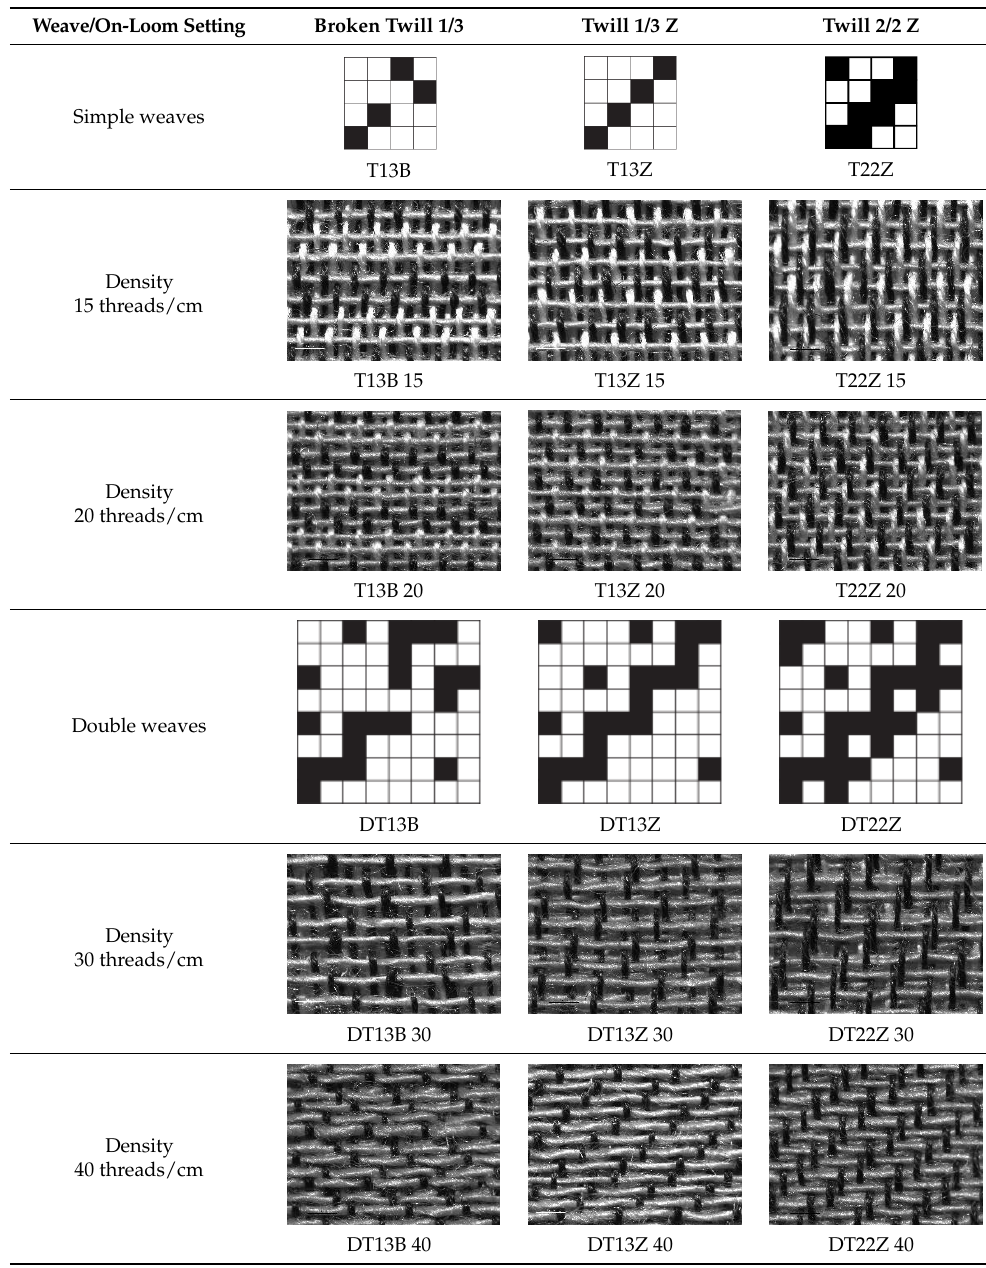
Table 1. Woven fabric samples (mag. 20 × ) with their designations (the sample designation includes Table 1. Woven fabric samples (mag. 20×) with their designations (the sample designation includes Table 1. Woven fabric samples (mag. 20×) with their designations (the sample designation includes Table 1. Woven fabric samples (mag. 20×) with their designations (the sample designation includes Table 1. Woven fabric samples (mag. 20×) with their designations (the sample designation includes Table 1. Woven fabric samples (mag. 20×) with their designations (the sample designation includes Table 1. Woven fabric samples (mag. 20×) with their designations (the sample designation includes Table 1. Woven fabric samples (mag. 20×) with their designations (the sample designation includes Table 1. Woven fabric samples (mag. 20×) with their designations (the sample designation includes Table 1. Woven fabric samples (mag. 20×) with their designations (the sample designation includes Table 1. Woven fabric samples (mag. 20×) with their designations (the sample designation includes Table 1. Woven fabric samples (mag. 20×) with their designations (the sample designation includes Table 1. Woven fabric samples (mag. 20×) with their designations (the sample designation includes Table 1. Woven fabric samples (mag. 20×) with their designations (the sample designation includes the name of the weave structure and the preset number of threads per centimeter). the name of the weave structure and the preset number of threads per centimeter). the name of the weave structure and the preset number of threads per centimeter). the name of the weave structure and the preset number of threads per the name of the weave structure and the preset number of threads per centimeter). the name of the weave structure and the preset number of threads per centimeter). the name of the weave structure and the preset number of threads per centimeter). the name of the weave structure and the preset number of threads per centimeter).